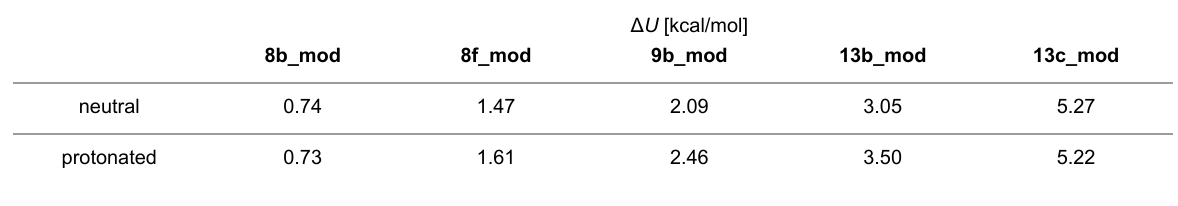
Table 1: Calculated differences in potential energy ( U ) of the modified compounds compared to compound 8a in water with MM. Differences were calculated by Δ U = U ( Cpd_mod or Cpd_mod’ ) – U ( 8a or 8a’